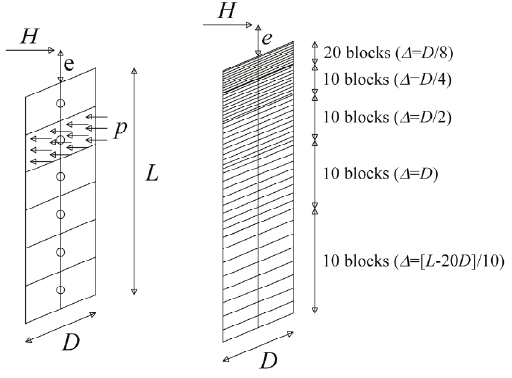
Figure 1. Pile—discretization.